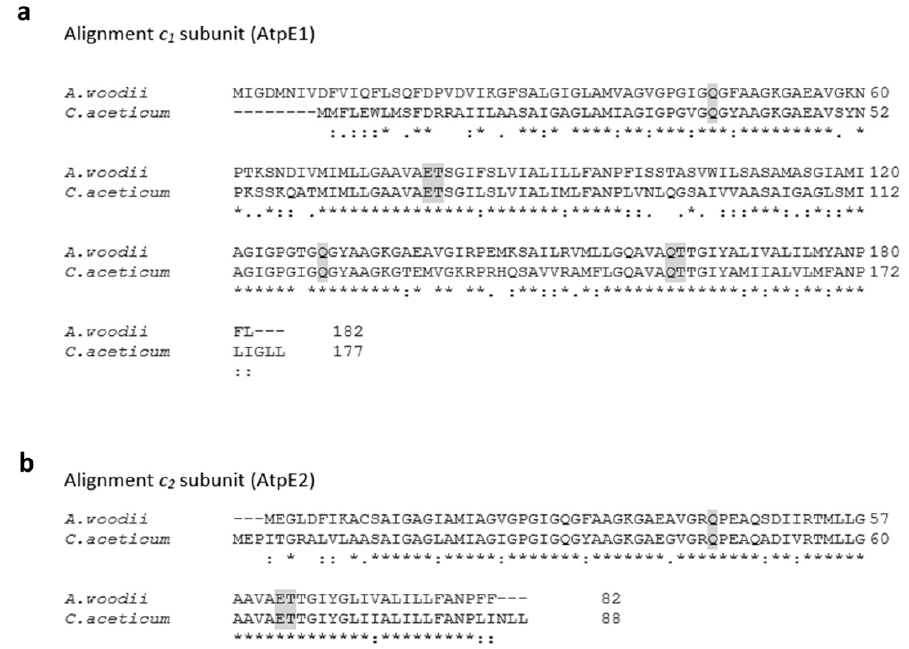
Figure 4. Alignment of the amino acids of subunits c 1 and c 2 of A. woodii and C. aceticum . Amino acids of the c 1 ( a ) and c 2 subunit ( b ), which are part of the c ring of the ATP synthase from A. woodii and C. aceticum were aligned using Clustal Omega. Highlighted in grey are the Na + -binding motif Q....ET of one hairpin of the c subunit and the second motif within a second hair pin without a functioning Na + -binding domain Q....QT.